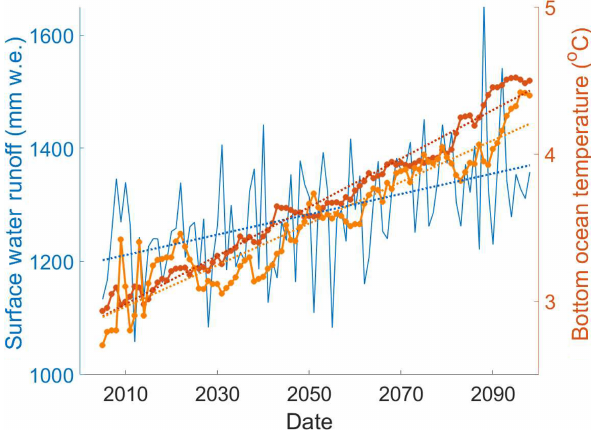
Figure 6. Climate forcing for future projection under the RCP4.5 scenario taken as 300m depth ocean temperatures from HadGEM2- ES (orange) compared with the ensemble mean (red) of seven Earth system models (HadGEM2-ES, BNU-ESM, MIROC-ESM, IPSL- CM5A-LR, CSIRO-Mk3L-1-2, NorESM1-M and MPI-ESM-LR) (right axis), with their linear trends. Annual maximum monthly sur- face water runoff near Jakobshavn Isbræ’s terminus from RACMO (forced by outputs from HadGEM2-ES) is shown in blue.